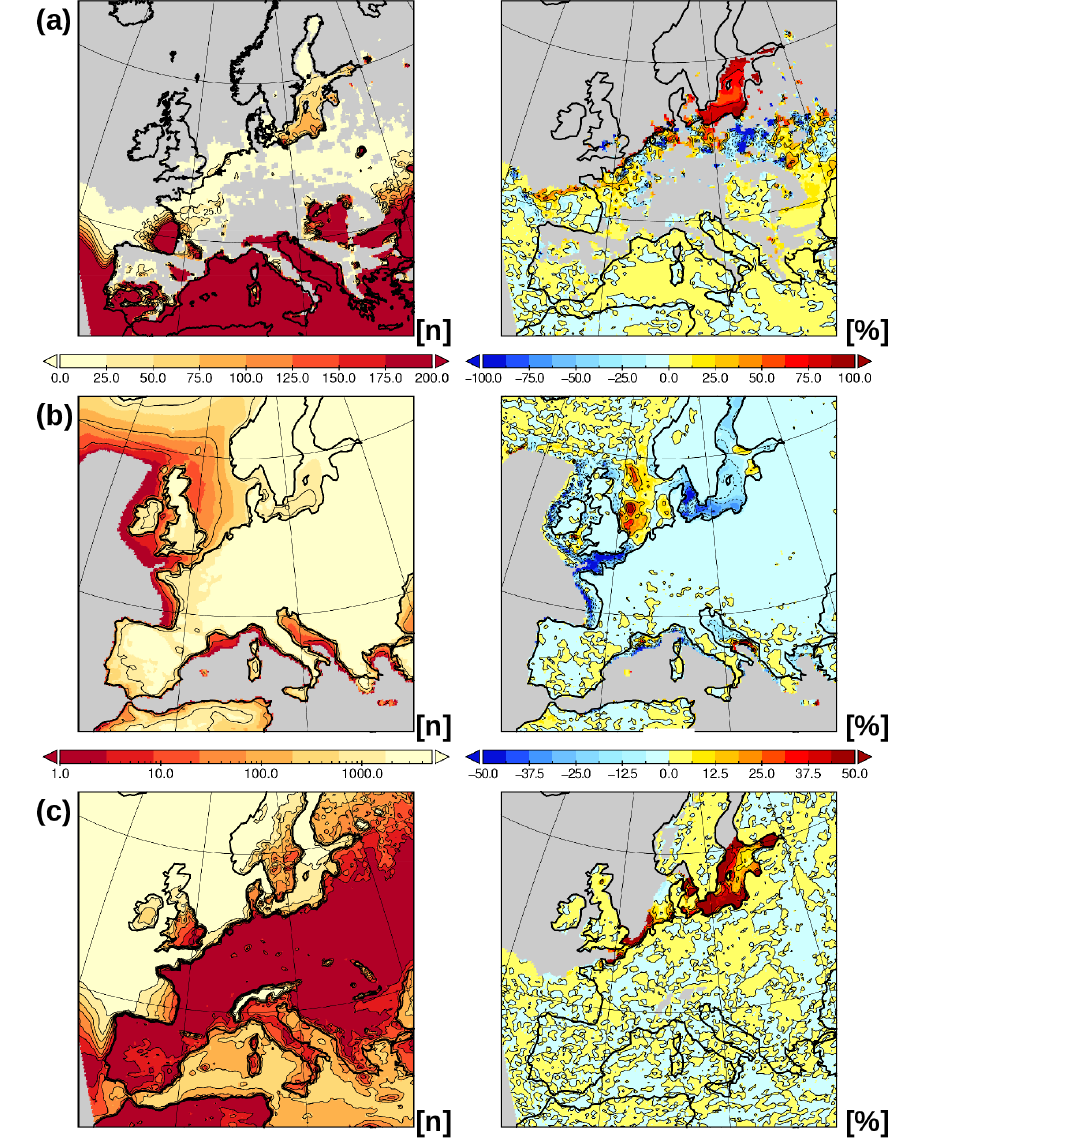
Figure 5. The left panel of (a) shows the number of tropical nights diagnosed from the coupled regional ocean–atmosphere model during the 1970–1999 reference period. The right panel of (a) displays the difference (%) of the coupled minus the uncoupled model. The panels in (b) are the same as those in (a) but for the number of frost days. The left panel of (c) shows the number of periods of at least 3 consecutive warm days (days when the daily maximum temperature exceeds 20 ◦ C). The right panel of (c) displays the difference (%) of the coupled minus the uncoupled